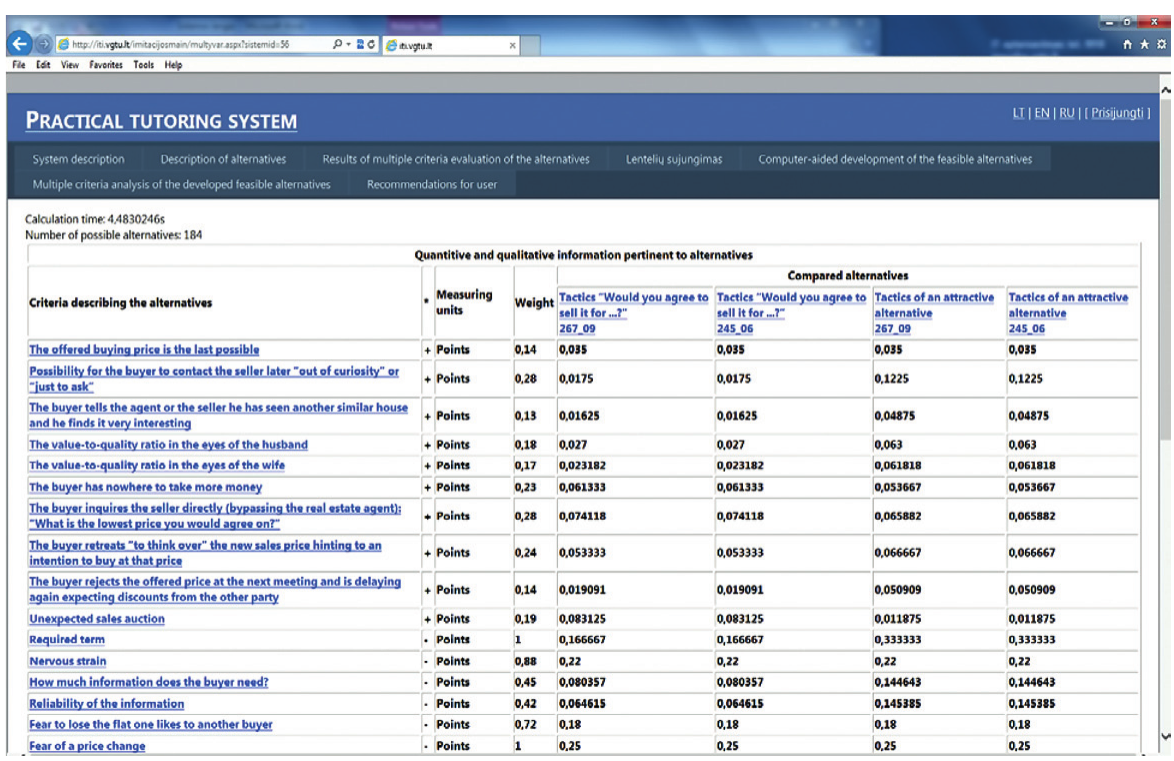
Fig. 7. The proportion of home sellers willing and not willing to bargain by their asking price compared to the market value